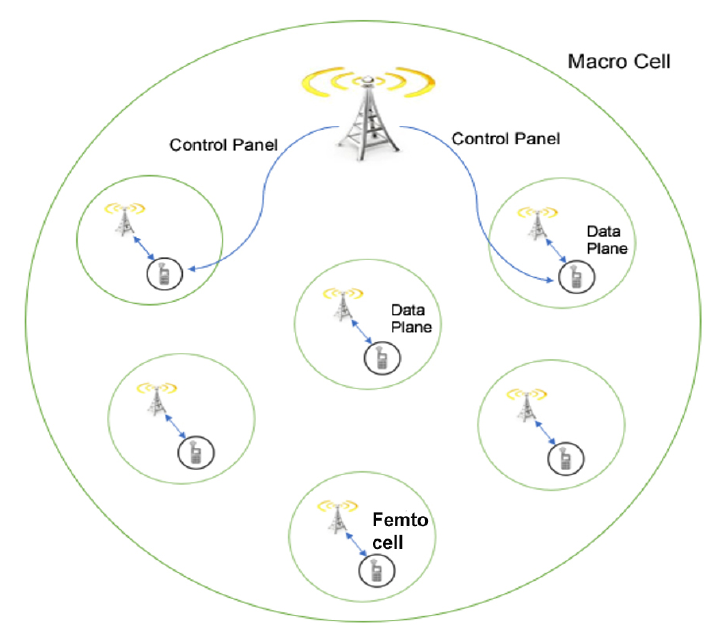
Figure 7. Heterogeneous